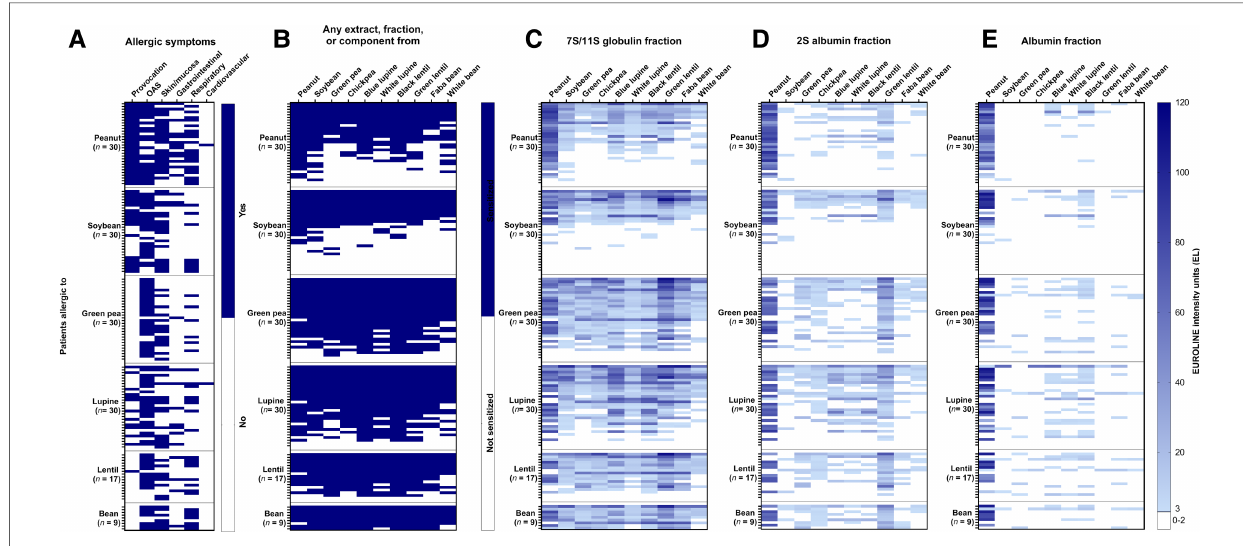
FIGURE 1 Heat maps showing the clinical details and frequency of co-sensitization for ten legumes in peanut, soybean, green pea, lupine, lentil, bean-allergic patient groups. Severity of the reaction and if diagnosis was based on food challenge (provocation) are shown in ( A ). Patients were ranked positive (blue) when IgE binding was found for either the non-processed or processed extract, the albumin, 2S albumin, or 7S/11S globulin fraction, or an individual protein ( B ). The EUROLINE intensity units were displayed for the 7S/11S globulin fractions ( C ), 2S albumin fractions ( D ), and albumin fractions ( E ), with darker shades of blue indicating a higher intensity of IgE binding. Each row in the different heat maps represent the same